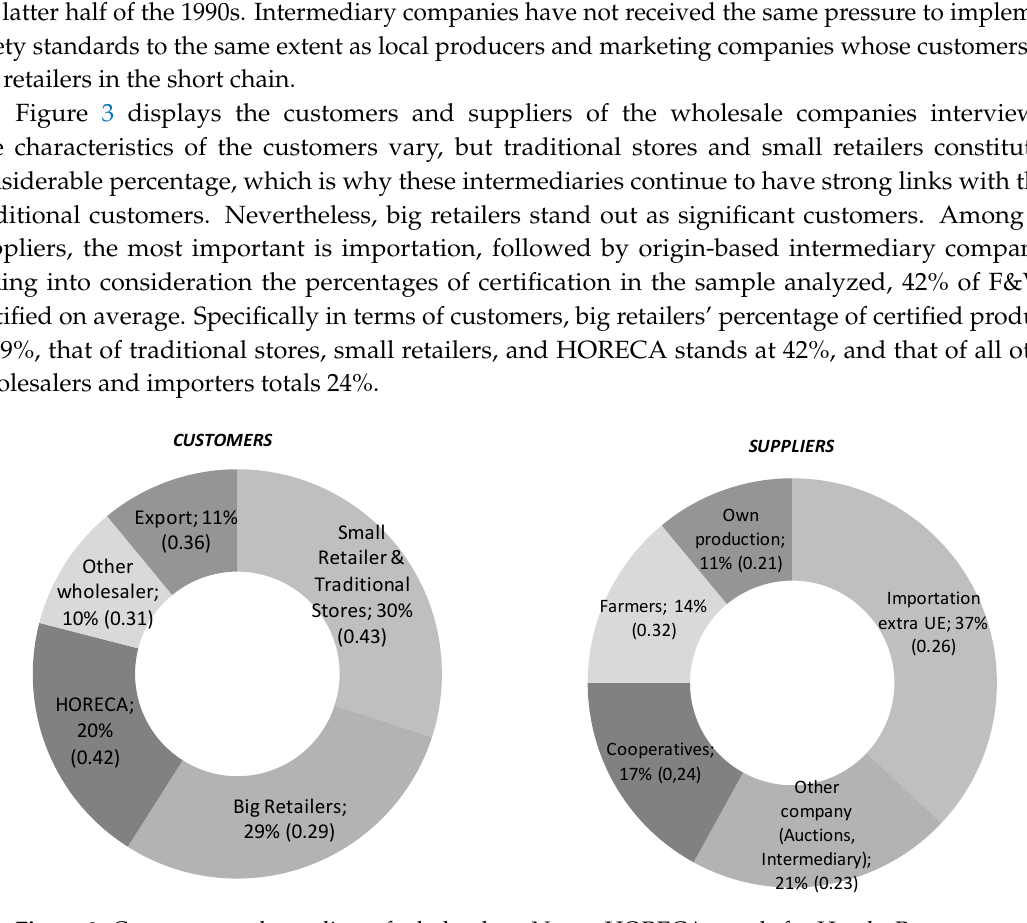
Figure 3. Customers and suppliers of wholesalers. Notes: HORECA stands for Hotels, Restaurants and Catering. In parentheses, standard deviation.